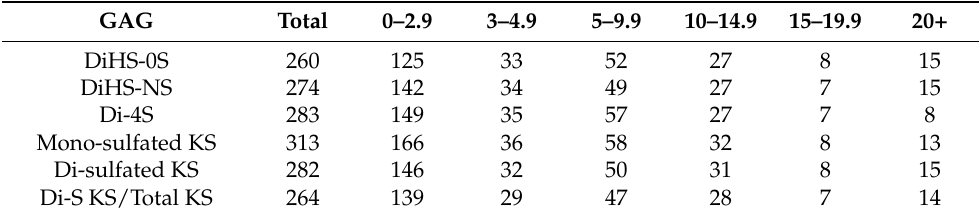
Table 2. Number of control values for each glycosaminoglycan (GAG) broken into age group. The GAG measurements included are O -sulfated heparan sulfate (DiHS-0S), N -sulfated heparan sulfate (DiHS-NS), dermatan sulfate (Di-4S), mono-sulfated keratan sulfate (Mono-S KS), di-sulfated keratan sulfate (Di-S KS), and the ratio of di-sulfated keratan sulfate to total keratan sulfate (Di-S KS/Total